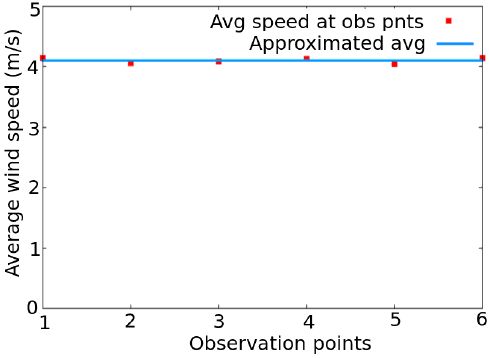
Figure 6. Average inlet reference velocity.